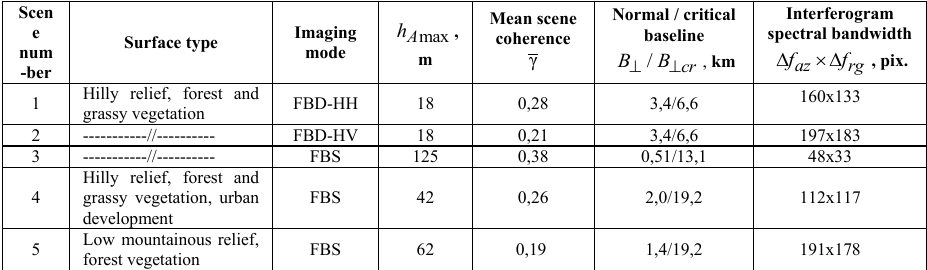
Table 1. Experimental data